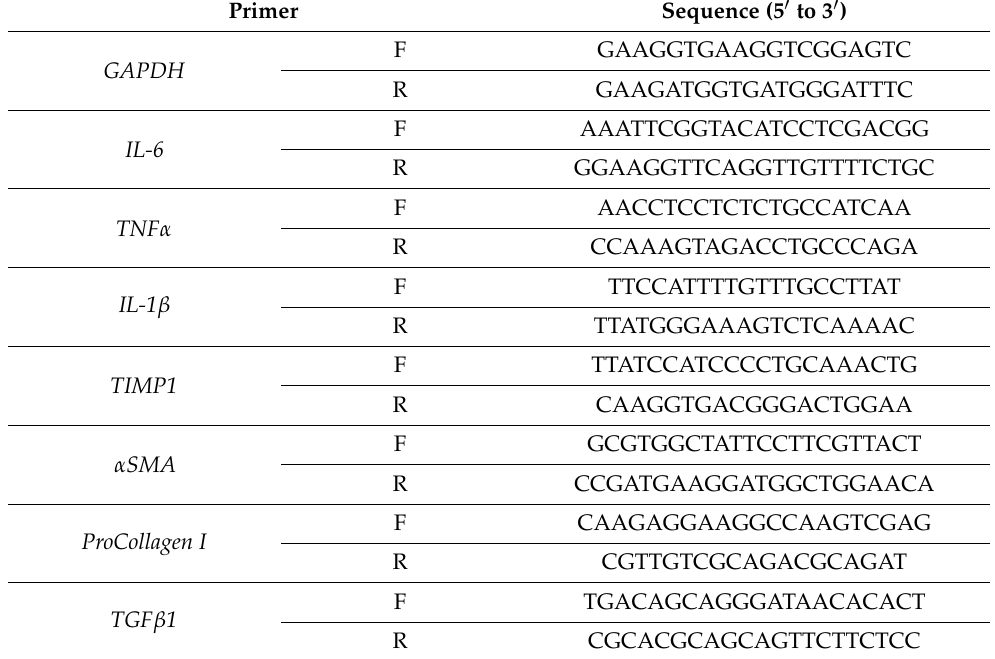
Table 1. Summary of forward (F) and reverse (R) sequences of human